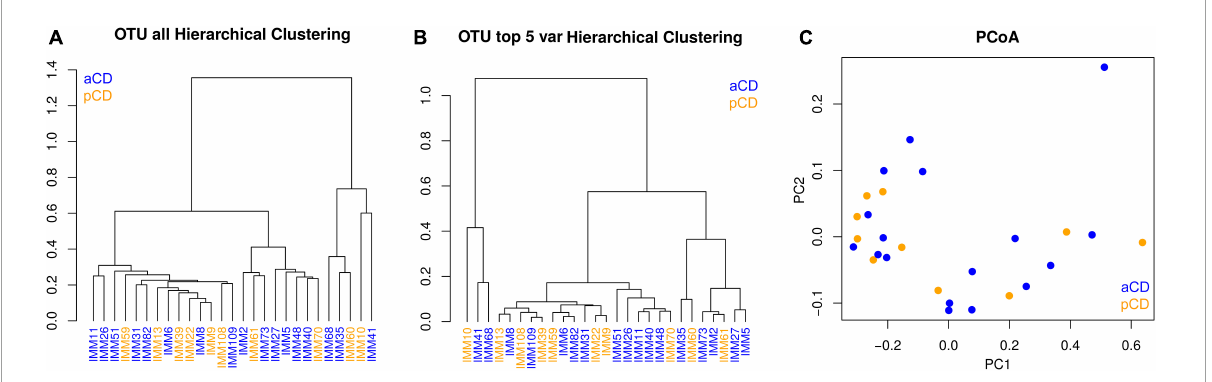
FIGURE3 Multivariate representations of the entire sample set. (A) Complete hierarchical clustering based on Euclidean distance of all identified OTUs, (B) complete hierarchical clustering based on Euclidean distance of the top five most informative OTUs, (C) principal coordinate analysis (PCoA) using Bray-Curtis dissimilarity as a distance metric.